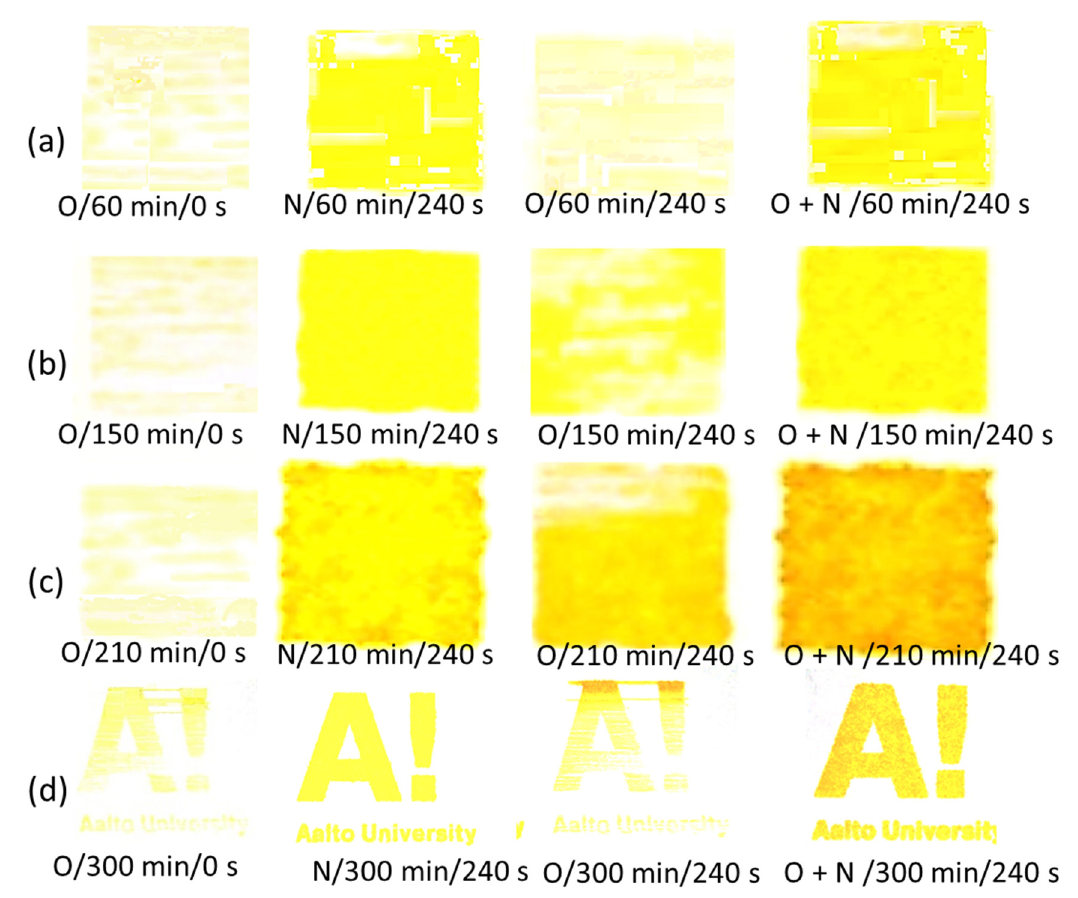
Figure 19. Ink-jet printing using drop on demand (DoD) printing method onto MNFC films, prior to and after O, N, and O + N plasma exposure; ( a ) with 60 min, ( b ) 150 min, ( c ) 210 min, and ( d ) 300 min enzymatic pretreatment.